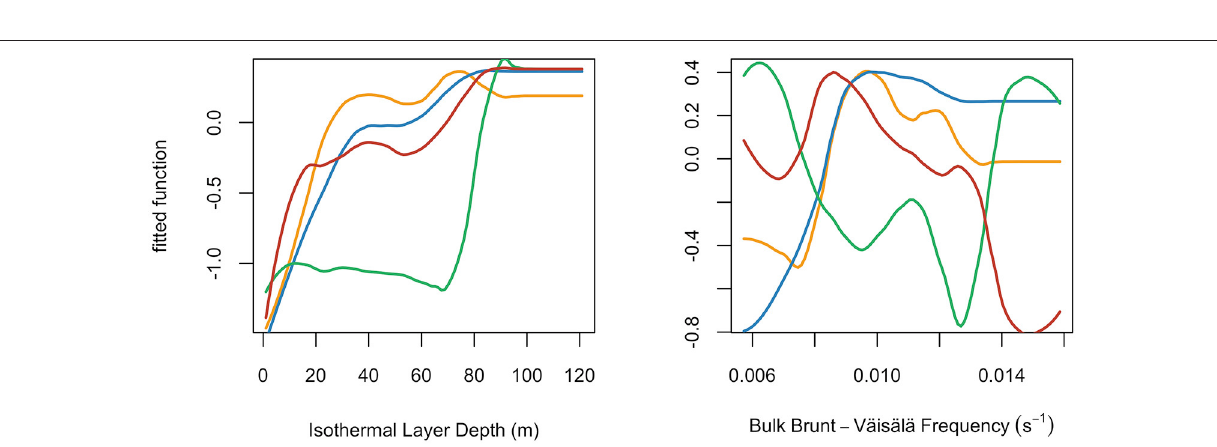
FIGURE 3 | Species partial response curves for two example variables, Isothermal Layer Depth and Bulk Brunt-Väisälä frequency. Species indicated by color: swordfish (yellow), blue sharks (blue), common thresher sharks (green), and shortfin mako sharks (red). Lines use a loess smoother fitted to the boosted regression tree response